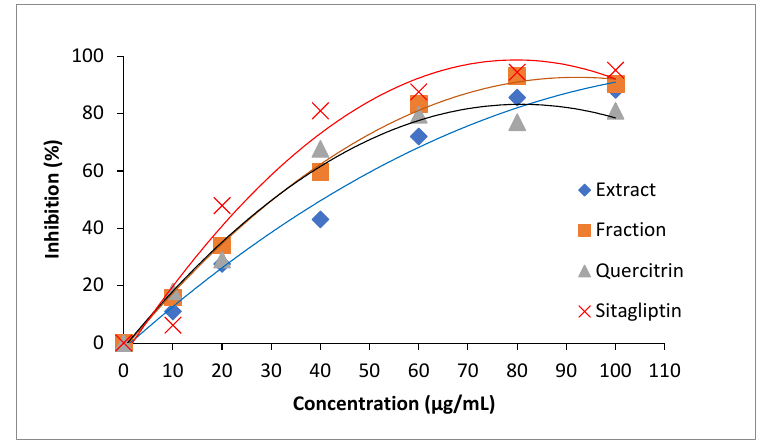
Figure 8. Inhibitory curves of dipeptidyl peptidase IV (DPP-IV) treated by crude extract ( (cid:7) ), plant fraction ( ■ ), standard quercetrin ( ▲ ), and sitagliptin (×).